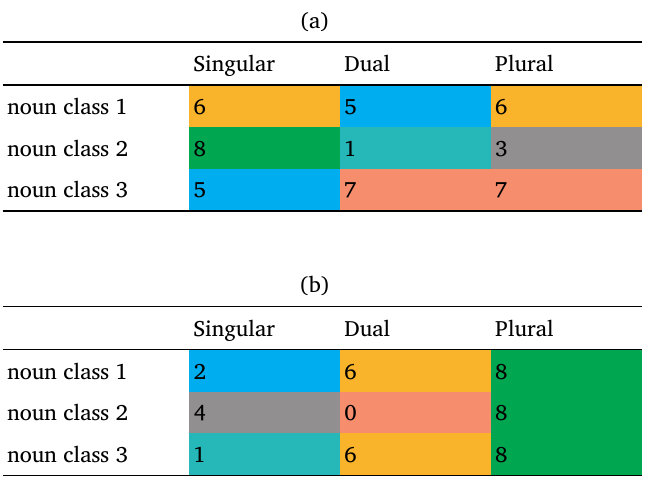
Table 5: Two example paradigms (with affixes indicated by integers) with six unique markers illustrating the inverse correlation between i-complexity and e-complexity when number of markers is constant: (a) has relatively high e-com- plexity (1.58 bits) and low i-complexity (0 bits), while (b) has relatively low e-complexity (0.83 bits) and relatively high i-complexity (0.52 bits). In (a) there are three different ways to mark each grammatical function (hence high e-com- plexity), and forms in all grammatical functions are predictive of all other forms (hence low i-complexity). In (b), on the other hand, there is only one realization for marking the plural number and two for marking dual (hence lower e-com- plexity), but in this organization the plural form is not predictive of forms in any other grammatical function and forms in dual do not fully predict the singular (hence higher